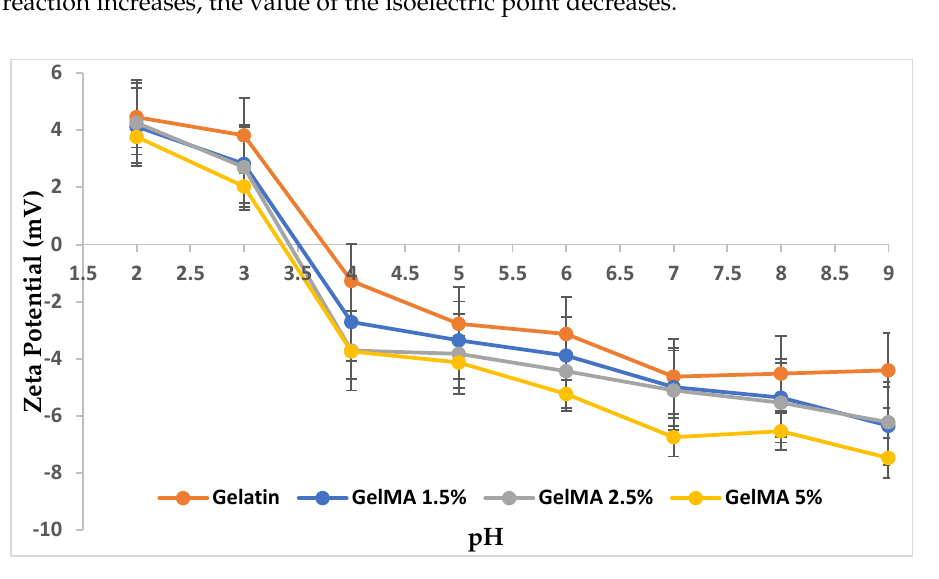
8 of 18 Figure 3. FTIR spectra of gelatin, GelMA1.5%; GelMA2.5%; GelMA5%.